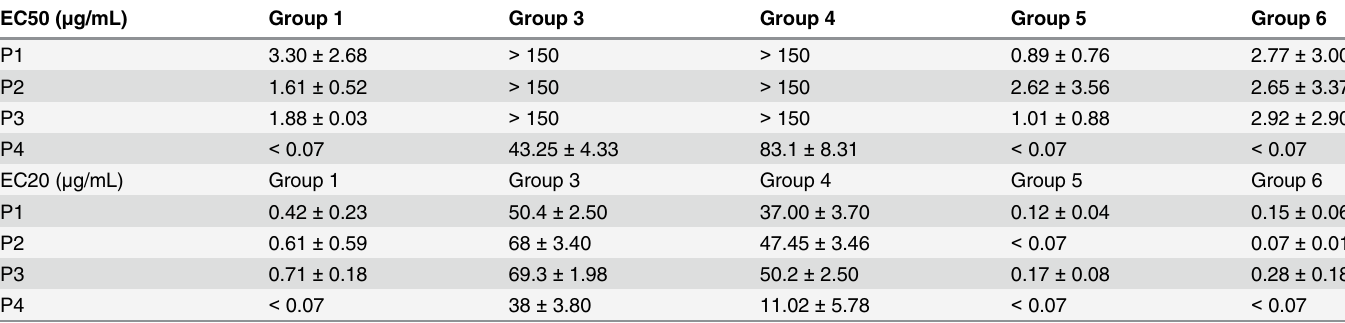
Table 2. Binding of bleed 4 IgGs to the isolated (poly)peptides by ELISA.